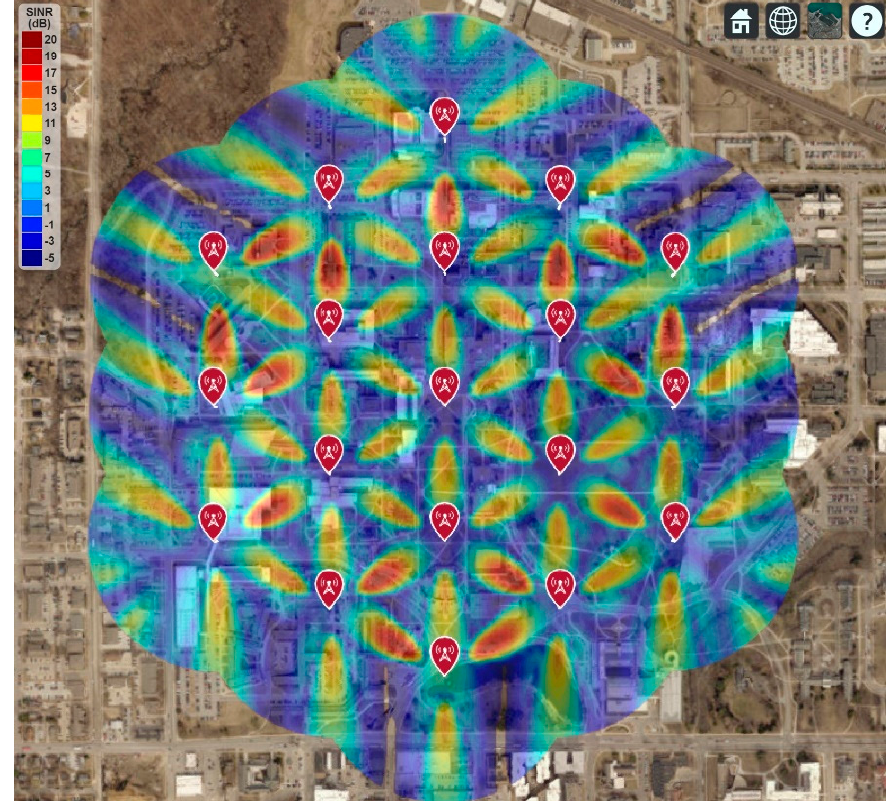
Figure 16. 5G Network Coverage and SINR Map for a single antenna element.